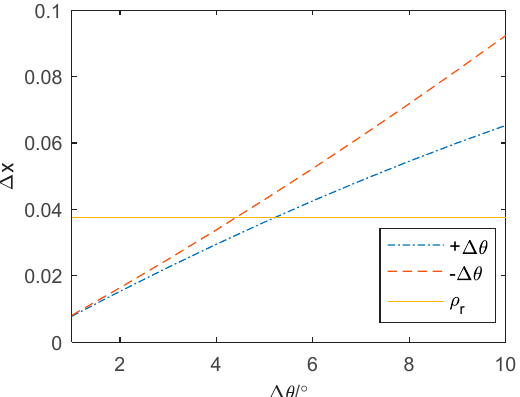
Figure 10. The relation between elevation calculation error and range resolution.